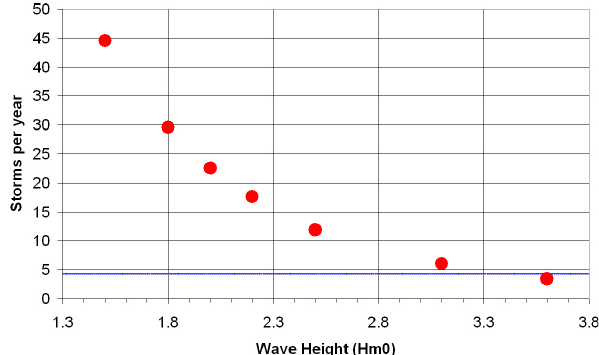
Fig. 3. Mean number of winter coastal storms obtained from HIPOCAS database using different wave height thresholds to clas- sify what a storm is (1.5m and percentiles 90 (1.8m), 92 (2.0m), 94 (2.2m), 96 (2.5m), 98 (3.1m) and 99 (3.6m)). The blue line shows the mean number of news reports about winter storms pub- lished in the